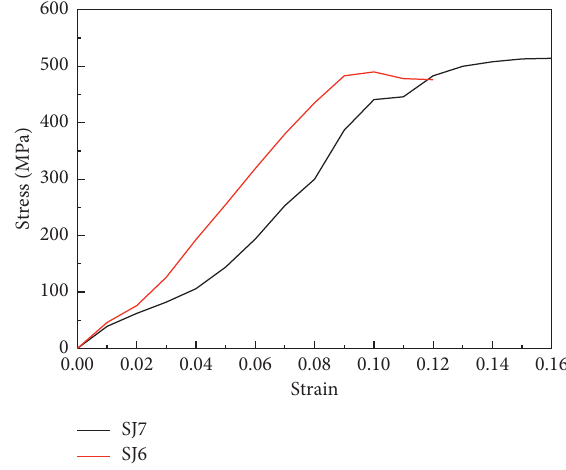
Figure 10: Stress-strain curves at different thickness